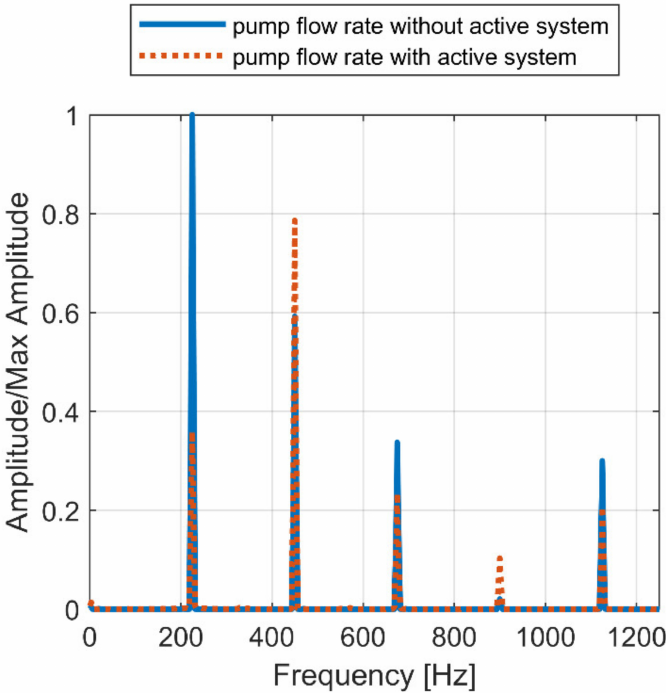
Figure 26. Simulation cycle 2, section 2: flow ripple FFT at 90 bar, 1500 rpm, 100% swash plate inclination.